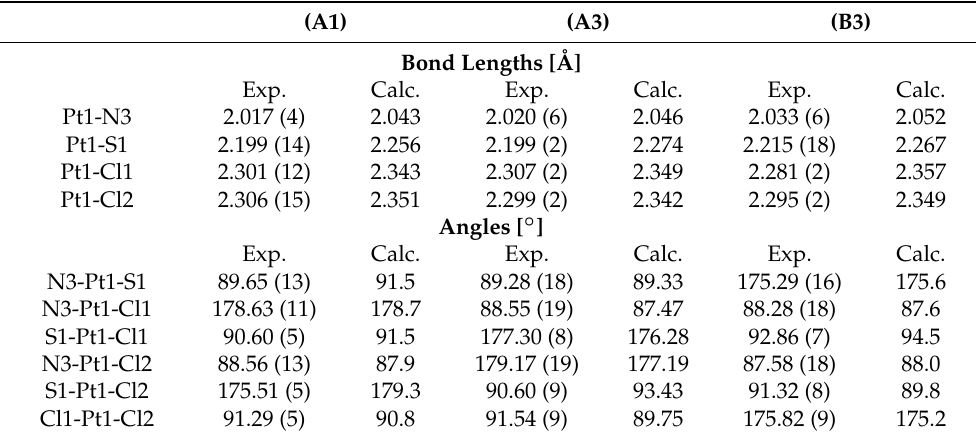
Table 1. Experimental and calculated selected bond lengths [Å] and angles [ ◦ ] for ( A1 ), ( A3 ), and ( B3